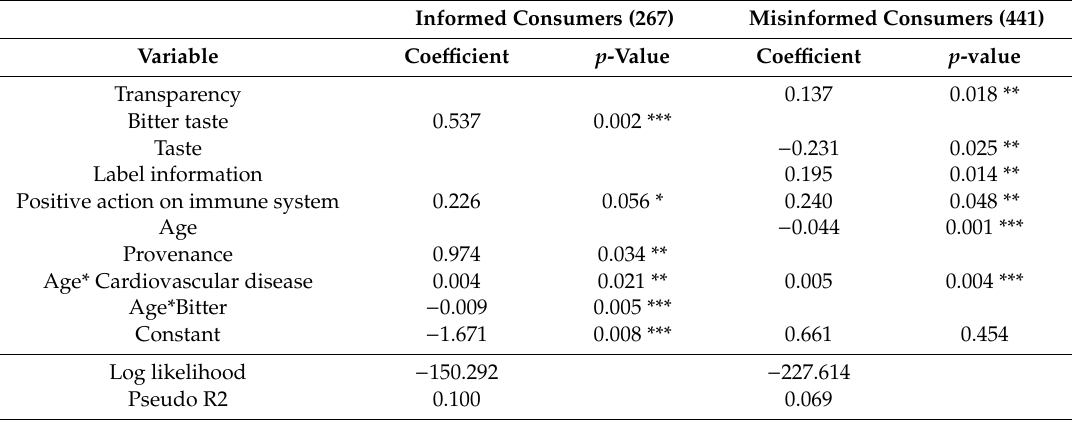
Table 5. Logistic regression of the attributes a ff ecting the consumption of olive oil with a high antioxidant content. Informed Consumers (267) Misinformed Consumers